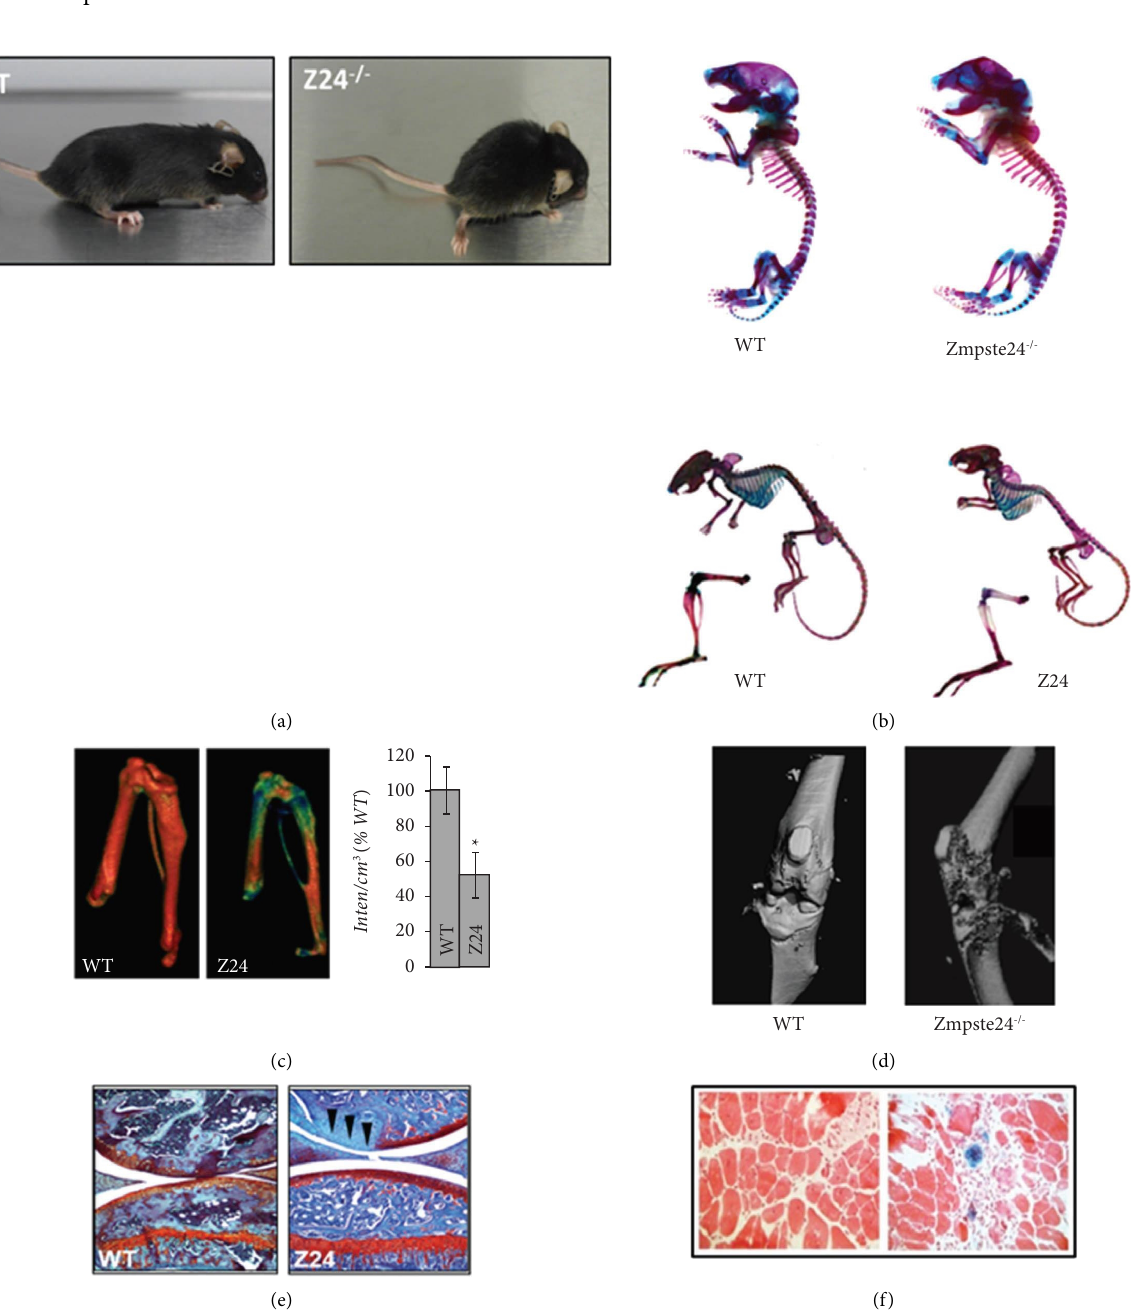
Figure 1: Musculoskeletal abnormalities in Zmpste24 − / − (Z24 − / − ) mice. (a) 4-month-old WT versus Z24 − / − mice indicating decreased weight and hunched posture. (b) Representative Alizarin red and Alcian blue staining of 4mo WT and Z24 − / − skeletal preparations. (c) Micro-CTmorphometry of hindlimbs indicating signifcant decrease in trabecular bone density in 4mo Z24 mice versus age-matched WT ( n � 6, ∗ P ≤ 0 . 05). (d) Representative radiographic images of Z24 − / − knee joint versus WT showing symptoms of OA. (e) Representative Safranin O staining highlighting spontaneous proteoglycan loss in articular cartilage of 4mo Z24 − / − mice ( n � 3, P ≤ 0 . 05). (f) Representative image of skeletal muscle section demonstrating senescent cell presence in WT versus Z24 − / − mice ( n � 3, ∗ P ≤ 0 .